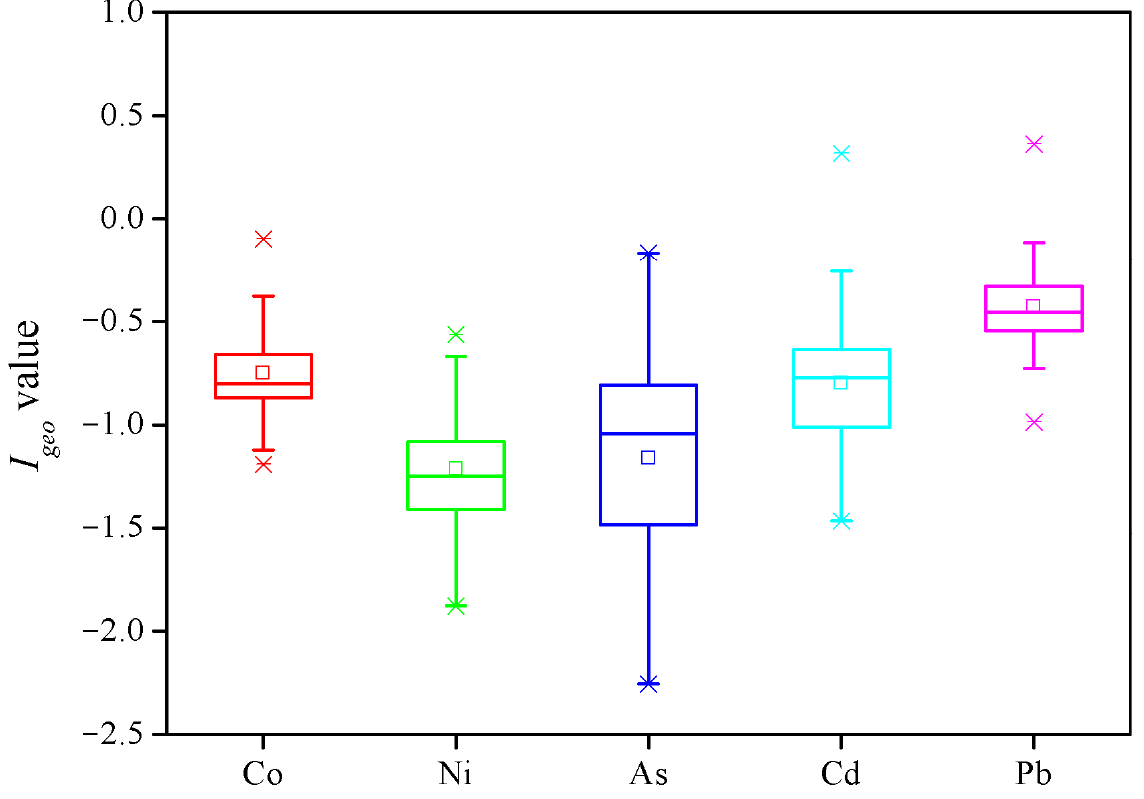
Figure 3. Geoaccumulation index for metal elements in sediments from the S. alterniflora wetland in the Yellow River Delta.